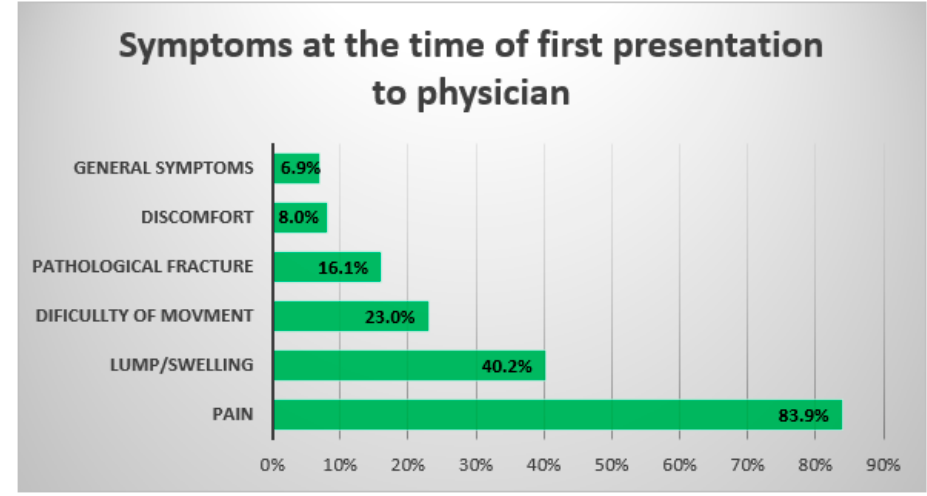
Figure 2. Symptoms reported by patients in both groups at the time of the first visit to the physician.